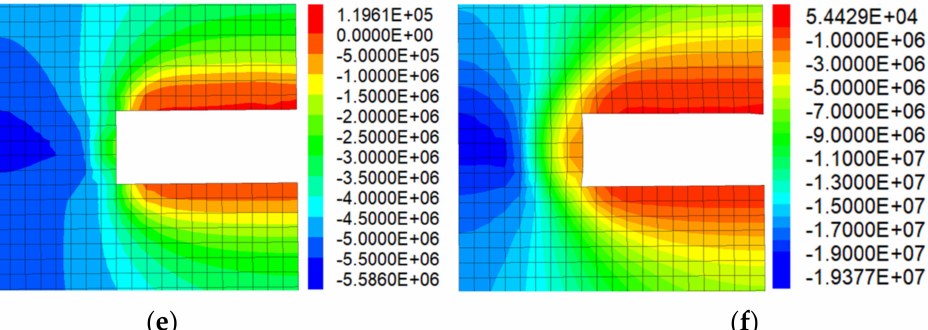
Figure 8. Vertical stress distribution law: ( a ) section of vertical roadway axis 11 m away from the heading face (shallow buried low-stress roadway); ( b ) section of vertical roadway axis 11 m away from the heading face (deeply buried high-stress roadway); ( c ) horizontal section when the parallel roadway is axially driven to 12 m (shallow buried low-stress roadway); ( d ) horizontal section when the parallel roadway is axially driven to 12 m (deeply buried high-stress roadway); ( e ) vertical section when the parallel roadway is axially driven to 12 m (shallow buried low-stress roadway); ( f ) vertical section when the parallel roadway is axially driven to 12 m (deeply buried high-stress